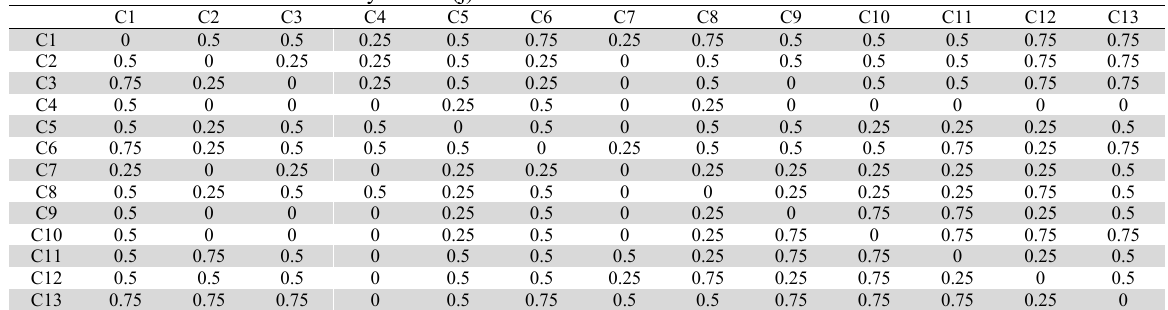
Normalized initial direct-relation fuzzy matrix (j)